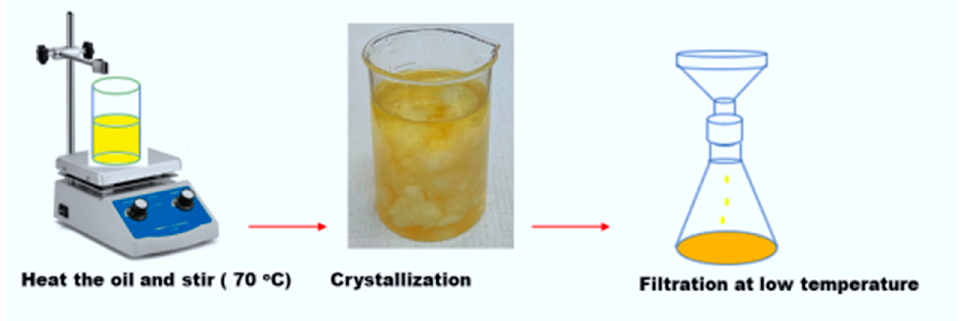
Figure 5. Fractional crystallization of natural esters.